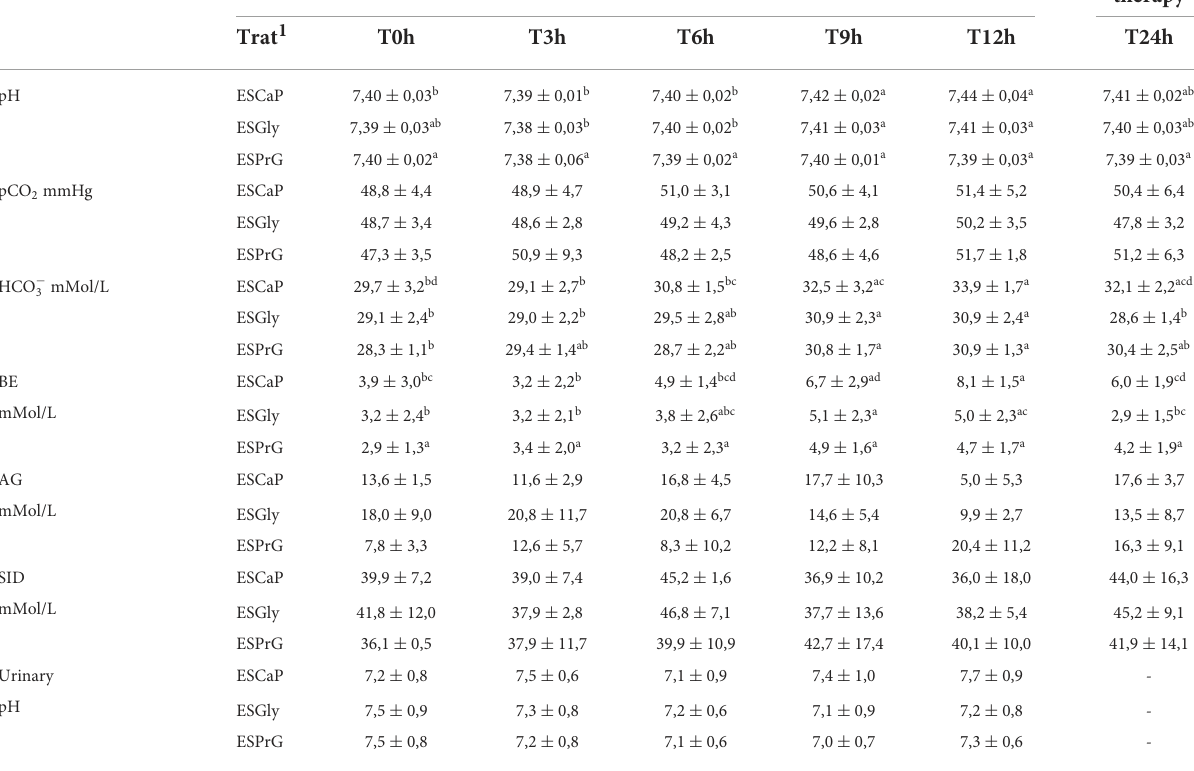
TABLE 4 Mean ± standard deviation of the blood gas parameters, anion gap (AG), strong ion difference (SID), and urinary pH in cattle submitted to continuous flow enteral fluid therapy with three electrolyte solutions containing different energy precursors.